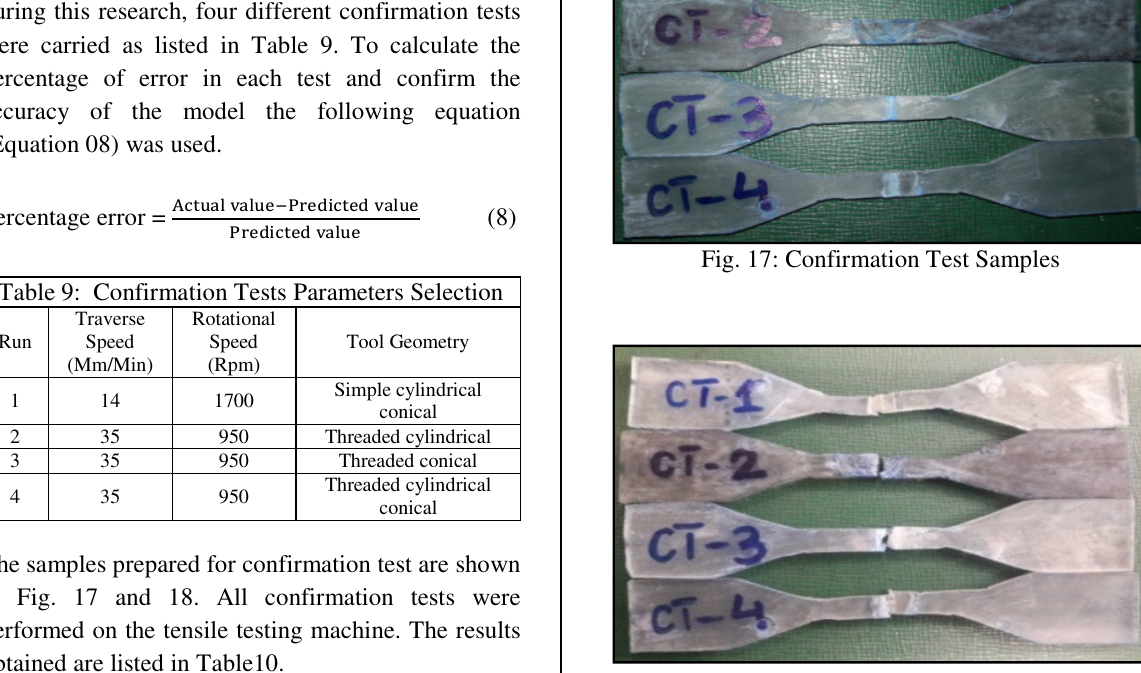
Fig. 18: Samples after Tensile